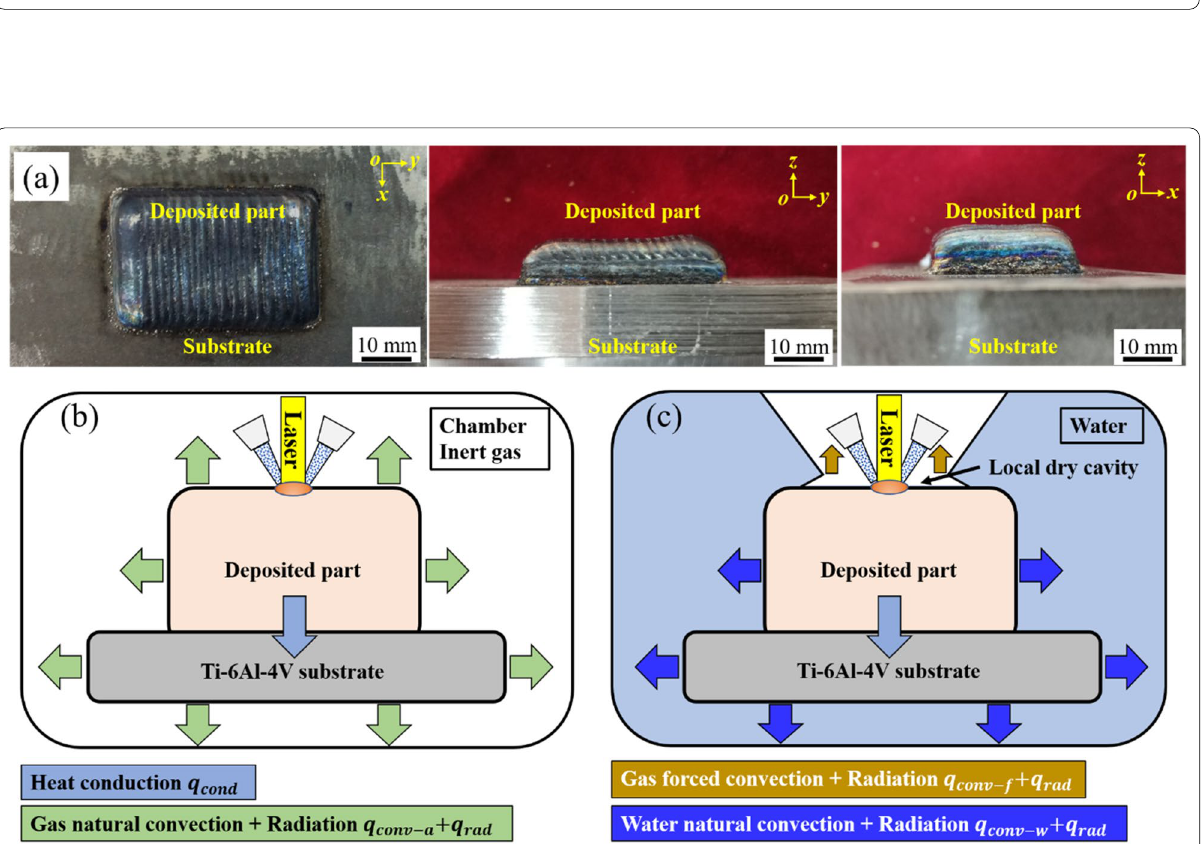
Figure 15 ( a ) Morphology of the ULDMD Ti-6Al-4V blocks and thermal boundary conditions for the ( b ) in-air DMD and ( c ) ULDMD (The arrows with different colors represent the modes of heat transfer)